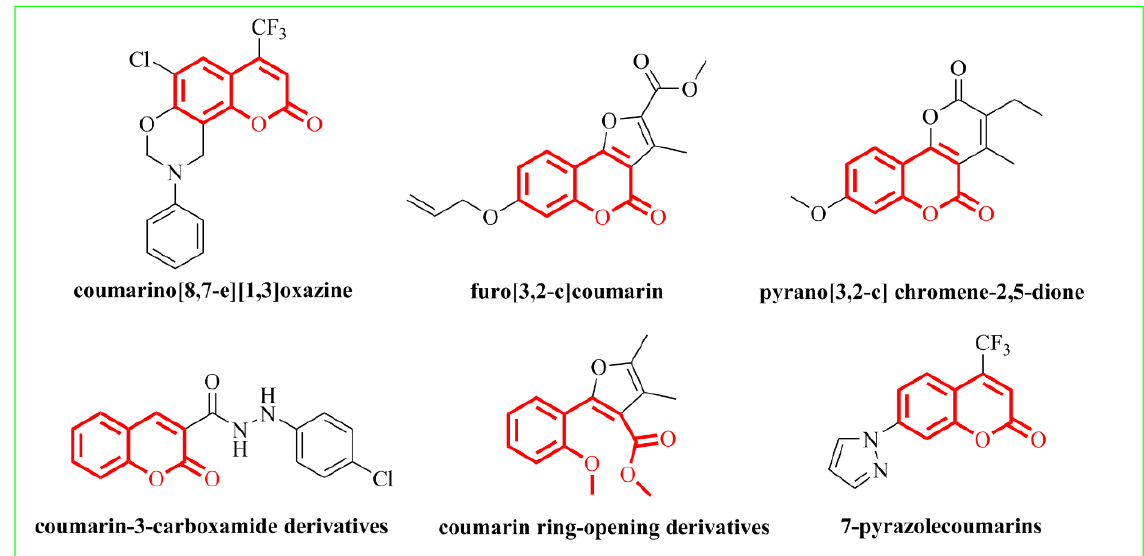
Figure 2. Our group’s previous work on coumarin derivatives.